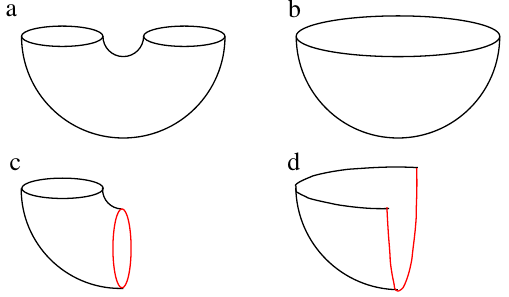
Figure 28 . Euclidean path integral geometries de(cid:12)ning (a) thermo(cid:12)eld double state of two CFTs (b) the vacuum state of a single CFT (c) a black hole microstate (d) a microstate for a half space. The red curves indicate BCFT boundary